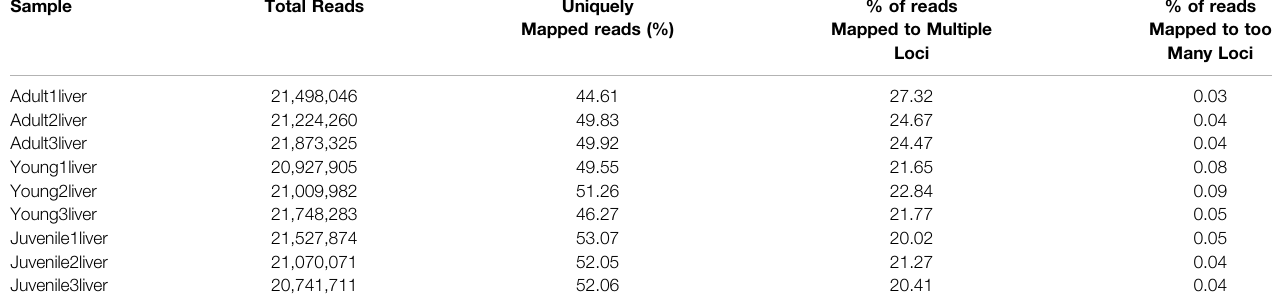
TABLE 2 | Statistical table of comparison results between the second-generation sequencing data and the third-generation non-redundant transcripts. Sample